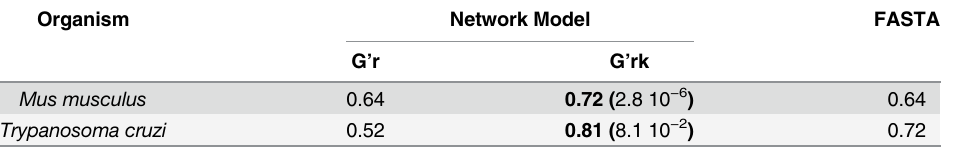
Table 5. Performance of the network at the task of prioritizing targets (cross-validation). AUC-0.1 nor- malized scores (McClish Correction [58]) for different prioritization strategies based on voting algorithm over G ’ r and G ’ rk (Network Model) and a sequence similarity (alignment-based) methodology (FASTA). The statis- tical significance of the difference between G ’ rk and FASTA AUC-01 values were evaluated through a 2,000 sample bootstrapping test and it is shown in